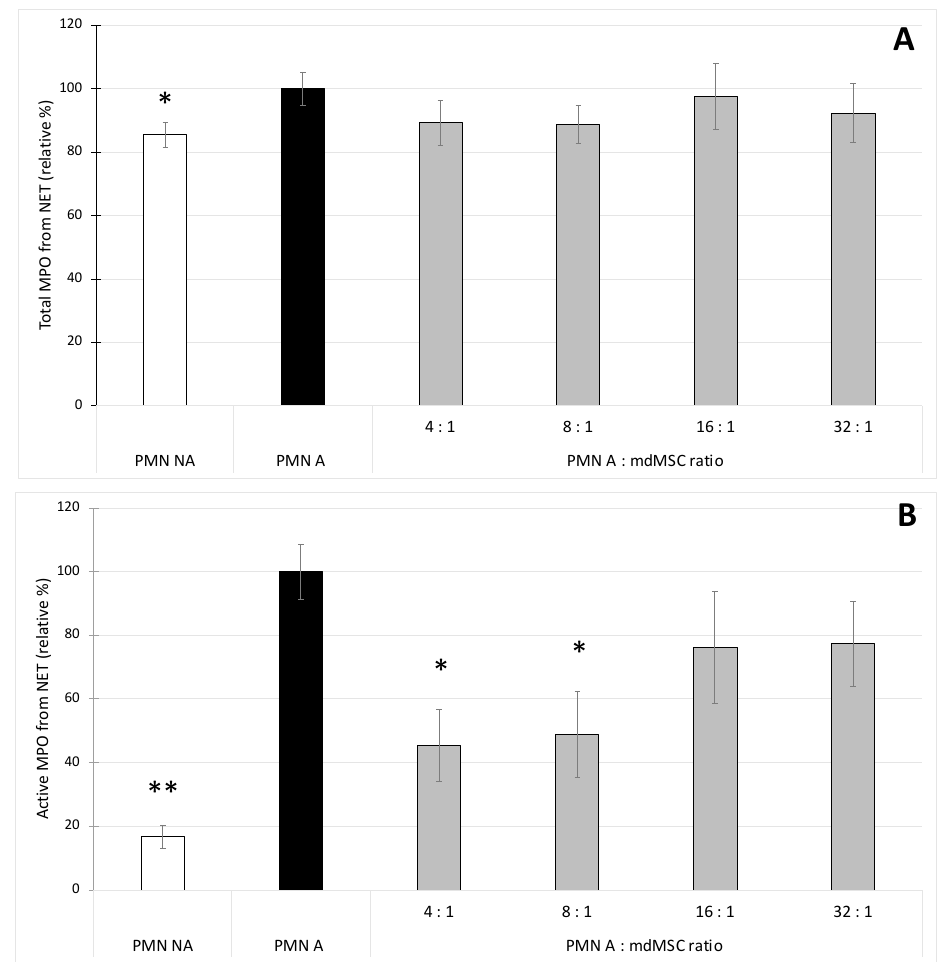
Figure 4. Effect of non-activated (PMN NA) and CB/fMLP-activated neutrophils (PMN A) alone or in coculture with mdMSCs at different ratios (PMN A:mdMSC ratio) on total ( A ) and active ( B ) MPO attached to the NET. Results from five independent experiments ( n = 5) with 2 technical replicates for each point, including 4 horses for mdMSCs, 5 horses for neutrophils. Means ± SD are shown in relative percentages versus stimulated neutrophils without mdMSCs (PMN A) defined as 100% response. Statistical analysis was considered for 5 independent experiments ** p < 0.01, * p < 0.05 vs. PMN A.